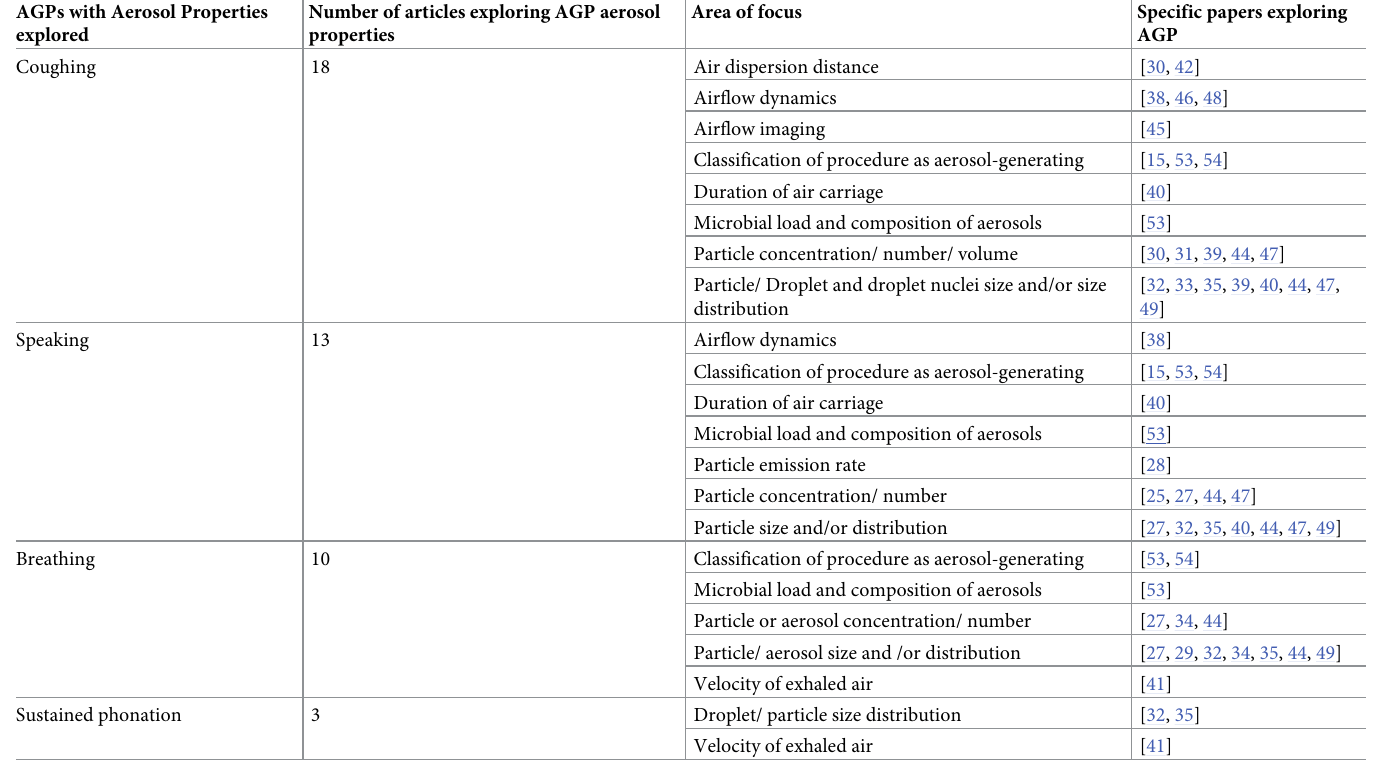
Table 3. Characteristics of identified AGPs based on evidence from the included